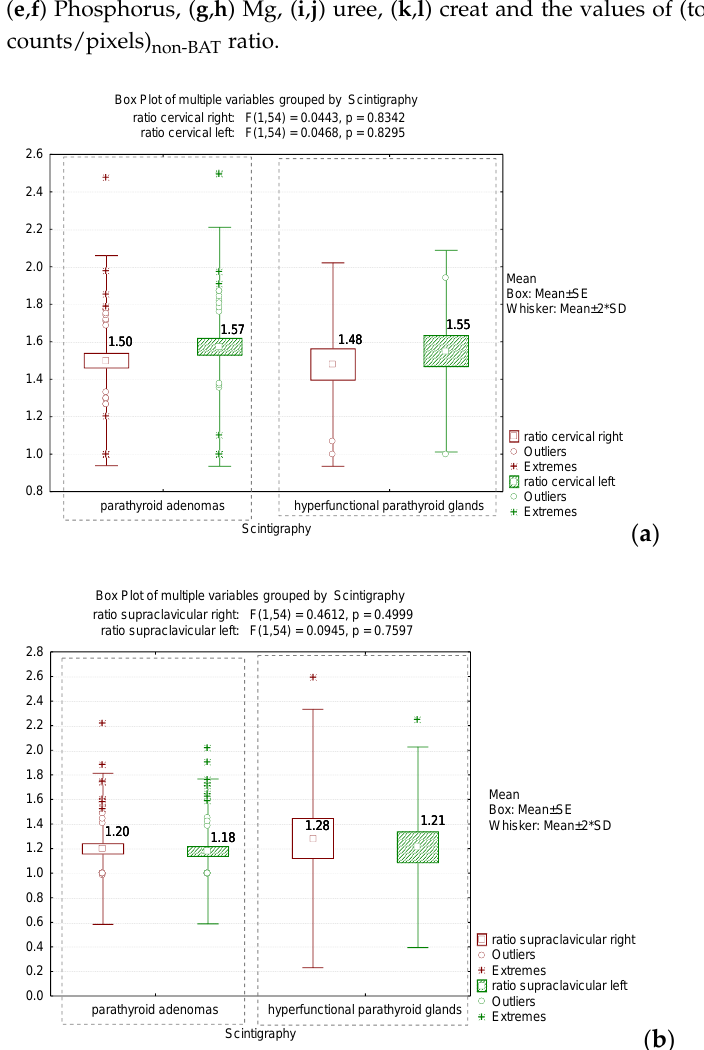
Figure 6. The comparison between mean values of the (total counts/pixels) BAT /(total counts/pixels) non-BAT ratio in the cervical ( a ) and supraclavicular regions ( b ), and the scintigraphic diagnosis. The analysis of the predictive values of the (total counts/pixels) BAT /(total counts/pixels) non-BAT ratio (Figure 7) indicated a cutoff for the right cervical ratio of 1.52 (AUC = 0.74, p = 0.036), with a sensitivity (Se) of 79% and a specificity (Sp) of 81%. Ratios higher than 1.52 indicated an increased probability of obesity. For the left cervical ratio, a cutoff of 1.72 was calculated with a Se = 93% and Sp = 79% ( p = 0.016). In the supraclavicular localization, only the right supraclavicular ratio values presented a cutoff with significant predictive power ( p = 0.029). Values lower than 1.15 indicated an increased probability of obesity (Se = 76%, Sp = 44%).